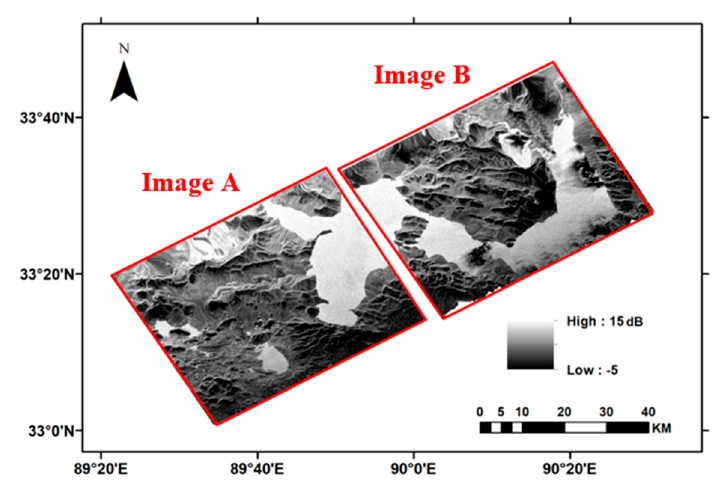
Figure 1. The InIRA observations over Nagqu area of Qinghai–Tibet Plateau (QTP).